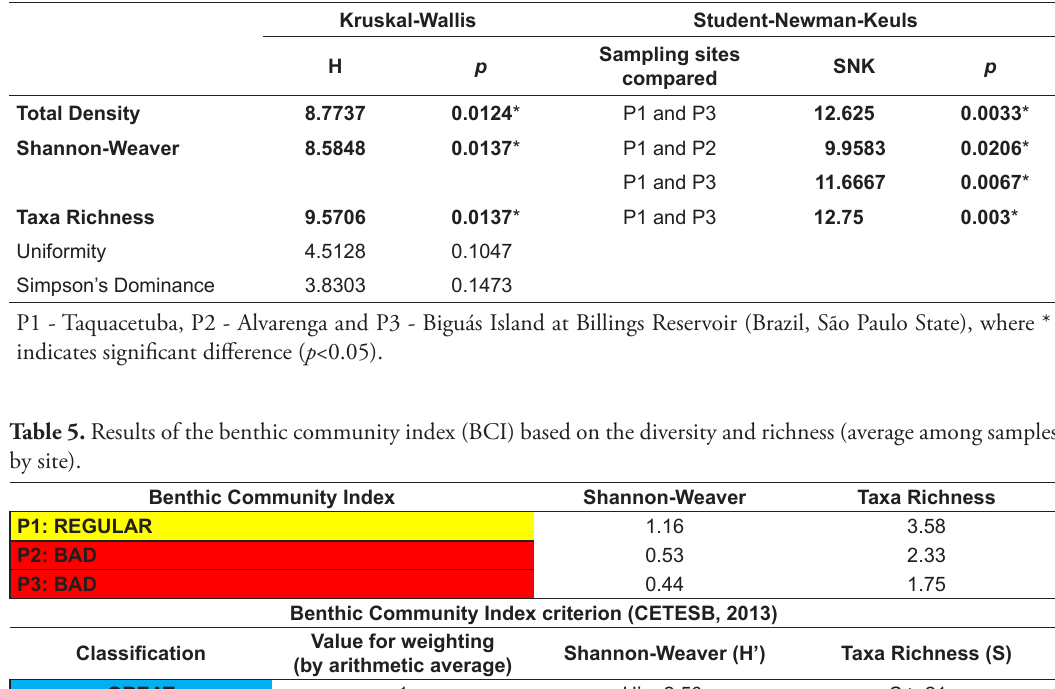
Table 4. Results of Kruskal-Wallis test (H) and subsequent Student-Newman-Keuls test (SNK) for biotic indices among the sampling